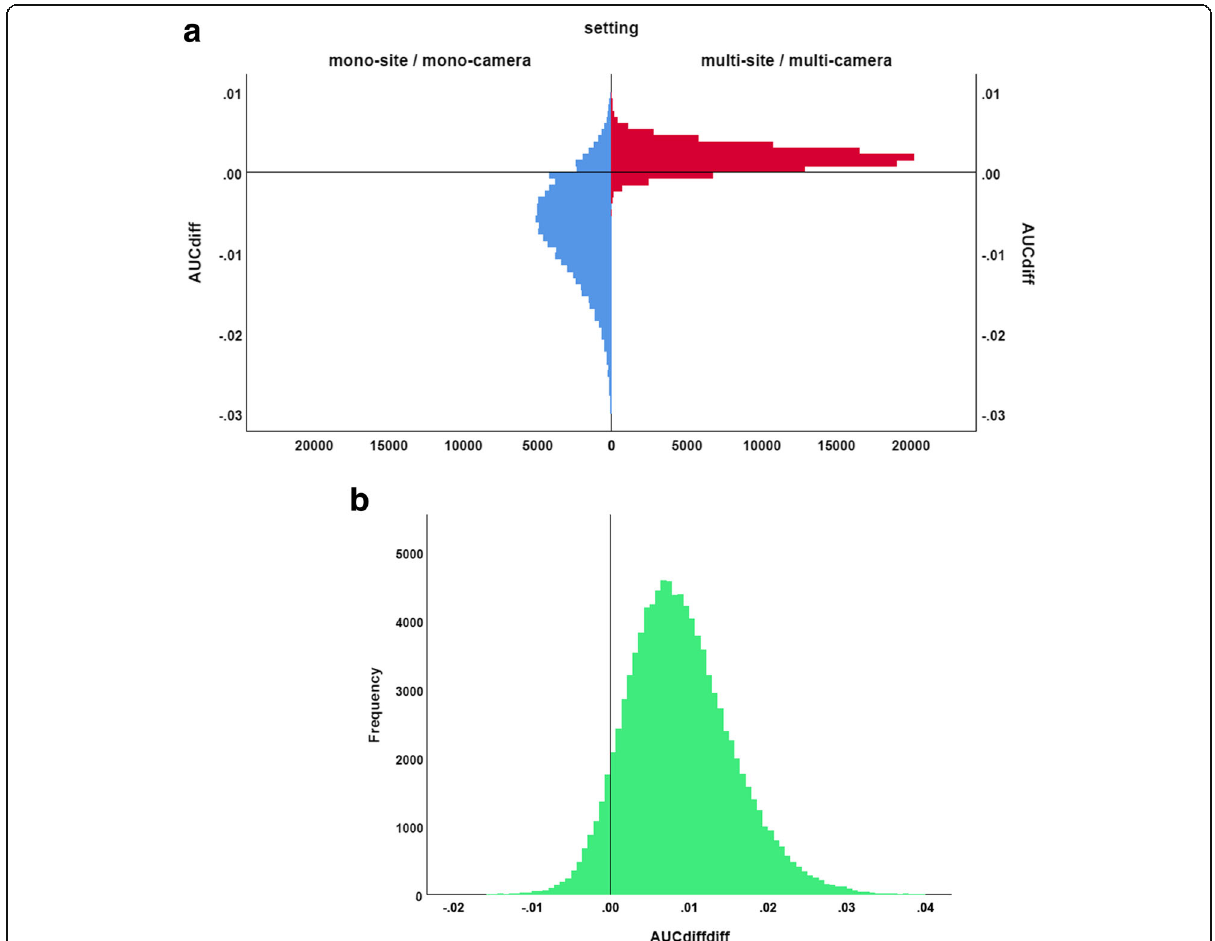
Fig. 6 Distribution of the performance difference AUC diff = (AUC SUSI – AUC SBR ) between putaminal SUSI and putaminal SBR in the mono-site/ mono-camera (MONO) setting and in the multi-site/multi-camera (MULTI) setting ( a ), and distribution of the double difference AUC diffdiff = AUC diff (MULTI) – AUC diff (MONO) ( b ). All distributions were estimated by bootstrapping with 100,000-fold